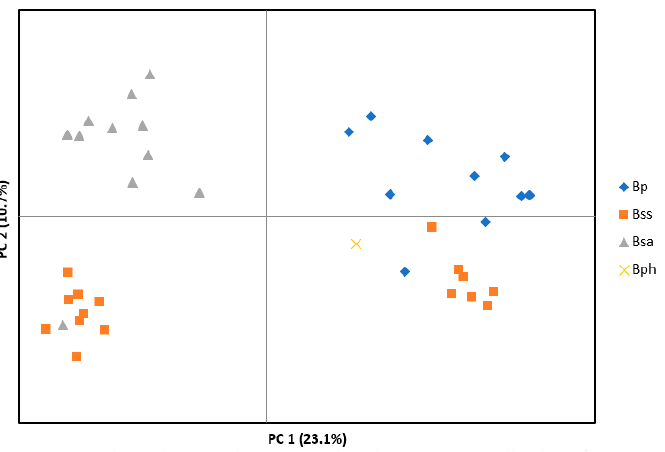
Figure 2. Principal coordinate analysis (PCoA) based on 16 microsatellite loci of Epichloë isolates from Brachypodium hosts: B. sylvaticum (Bss, sexual isolates; Bsa, asexual isolates), B. pinnatum (Bp) and B. phoenicoides (Bph).